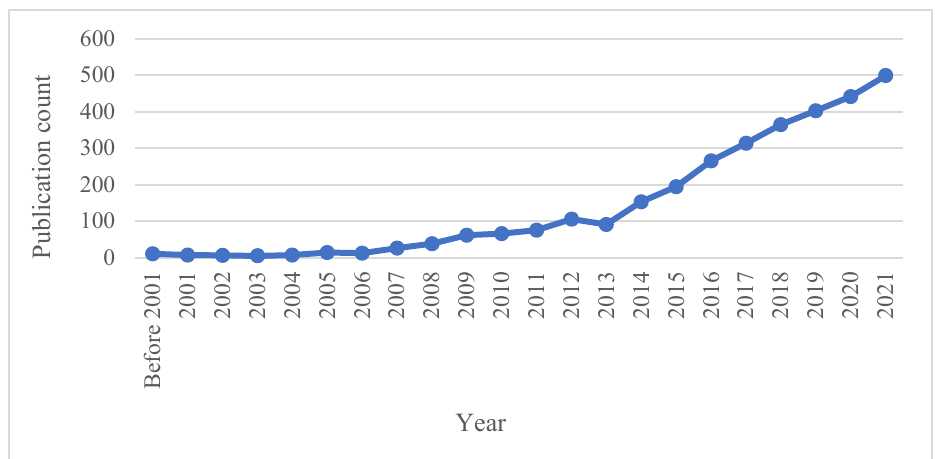
Figure 1. Publication timeline.